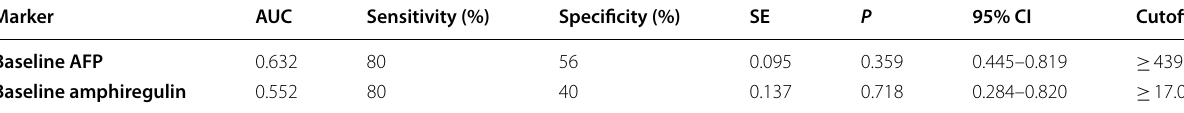
Table 10 Diagnostic performance of baseline AFP and amphiregulin in predicting tumor recurrence Marker AUC Sensitivity